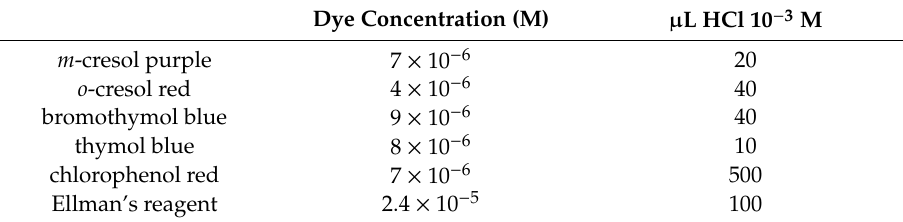
Table 1. Experimental conditions for the Colour Catcher ® (CC) spot sensors